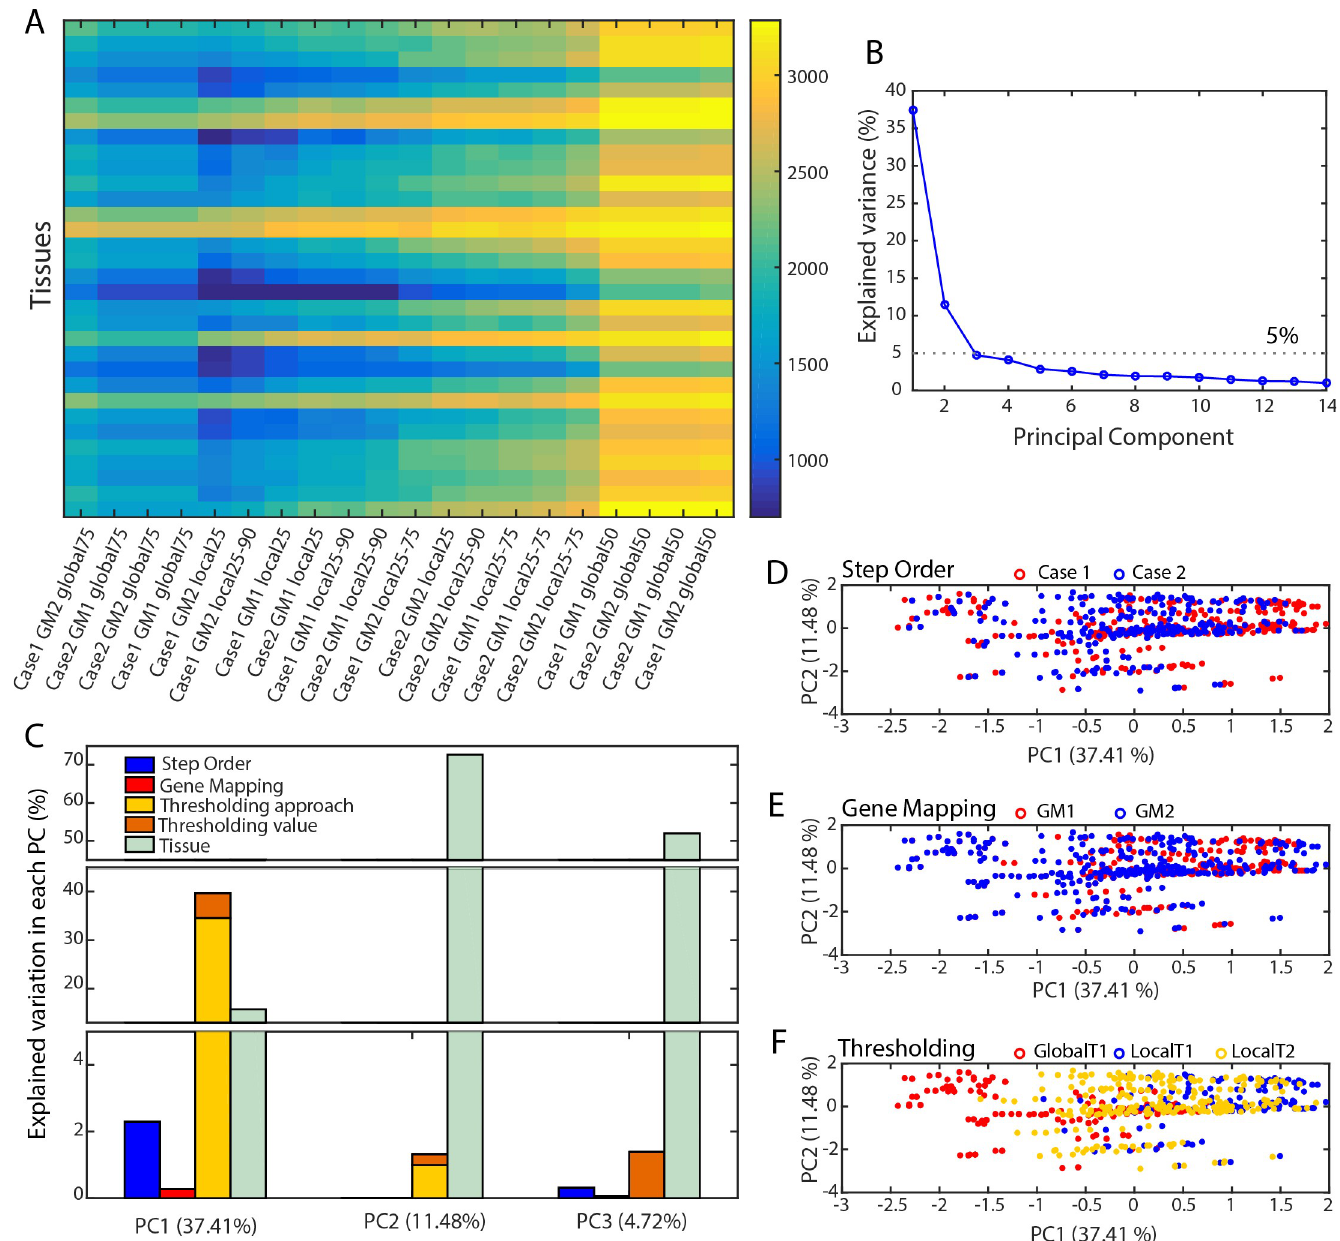
Fig 2. Preprocessing decisions affect the definition of active reactions sets. (A) Twenty different combinations of preprocessing decisions led to a large diversity number of reactions considered as active. (B) The first three principal components (PCs) explain most of the variance in the number of active reactions in a GEM. (C) Thresholding contributes the most to the first PC and more specifically the main contributor is the thresholding approach (i.e. local or global). (D, E and F). The influence of thresholding parameter selection is clear in the first PC (F), while the networks are less influenced by the gene mapping method (E) and the order of preprocessing steps used